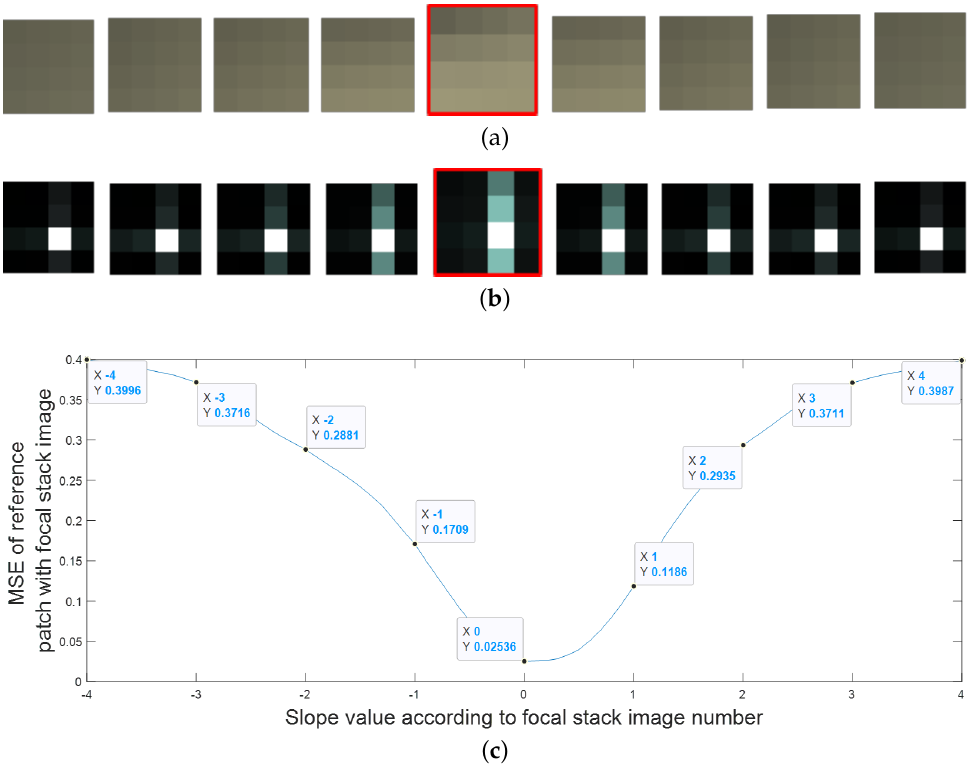
Figure 5. ( a ) The RGB image patch and ( b ) the FFT patch at different focal lengths. The patch with the red boundary is the closest match to the reference patch in Figure 4. ( c ) The graph shows the MSE values for the central image in Figure 4, with the corresponding focal stack image